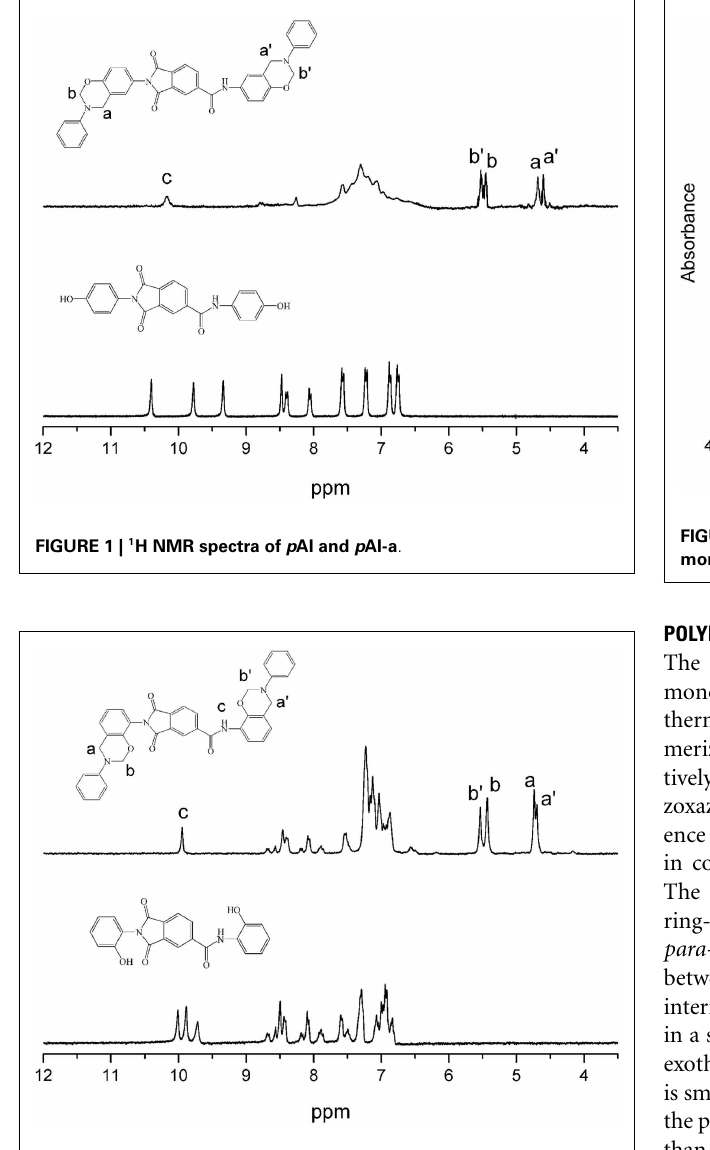
FIGURE 2 | 1 H NMR spectra of o AI and o AI-a .